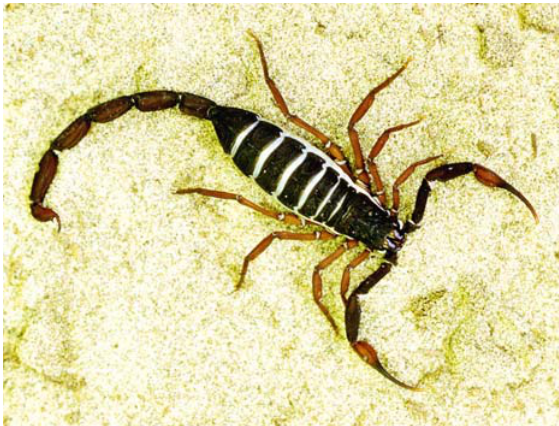
Figure 9. Female of Centruroides gracilis .